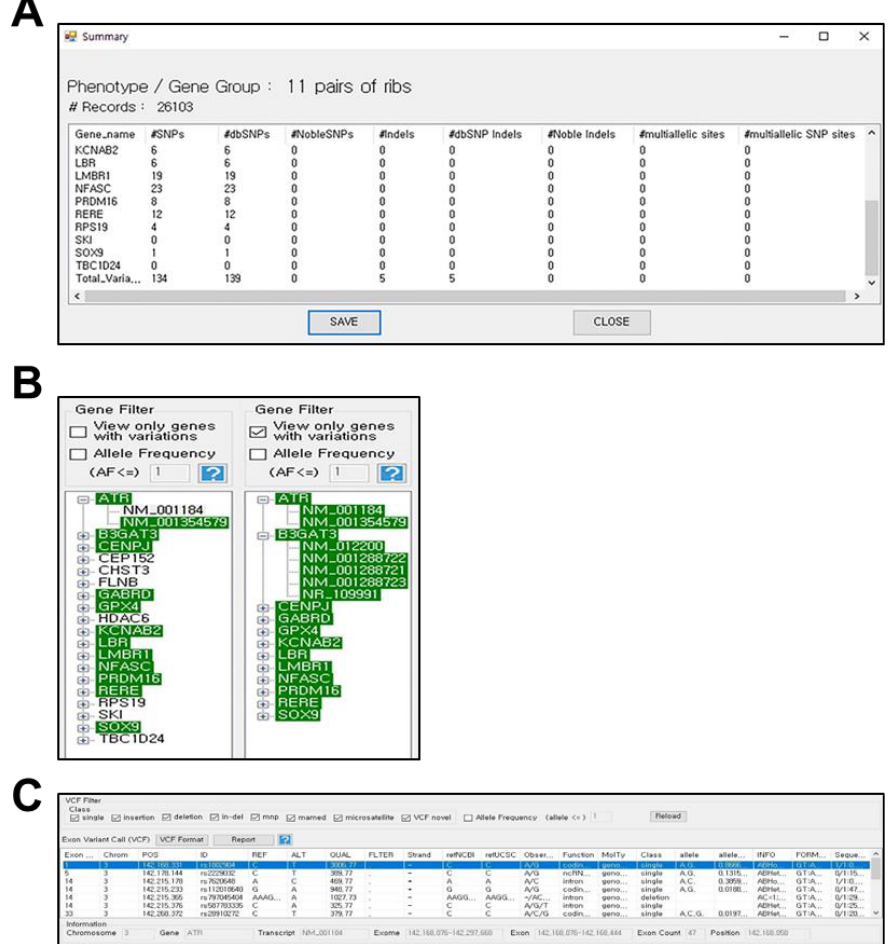
Figure 2. Output data of the exon variant information. ( A ) Statistical summary of the variant information from the VCF file. ( B ) Example of the gene filter panel and gene/transcript view panel. The genes and transcript with variants are highlighted with green color. ( C ) Example of the variant output in the VCF filter panel and the exon variant call panel.